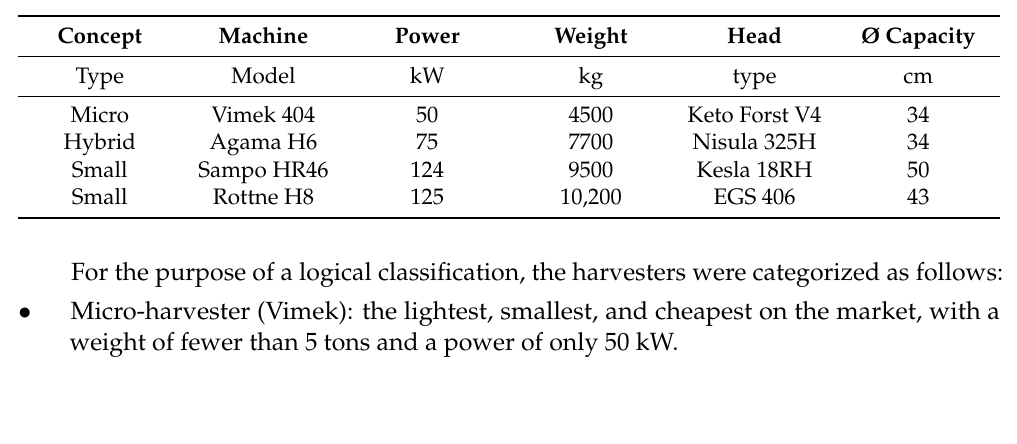
Figure 1. The four cut-to-length harvesters on test: Agama AH6 ( A ); Vimek 404 ( B ); Rottne H8 ( C ); Sampo HR46 ( D ). Table 1. Technical specifications of the four harvesters